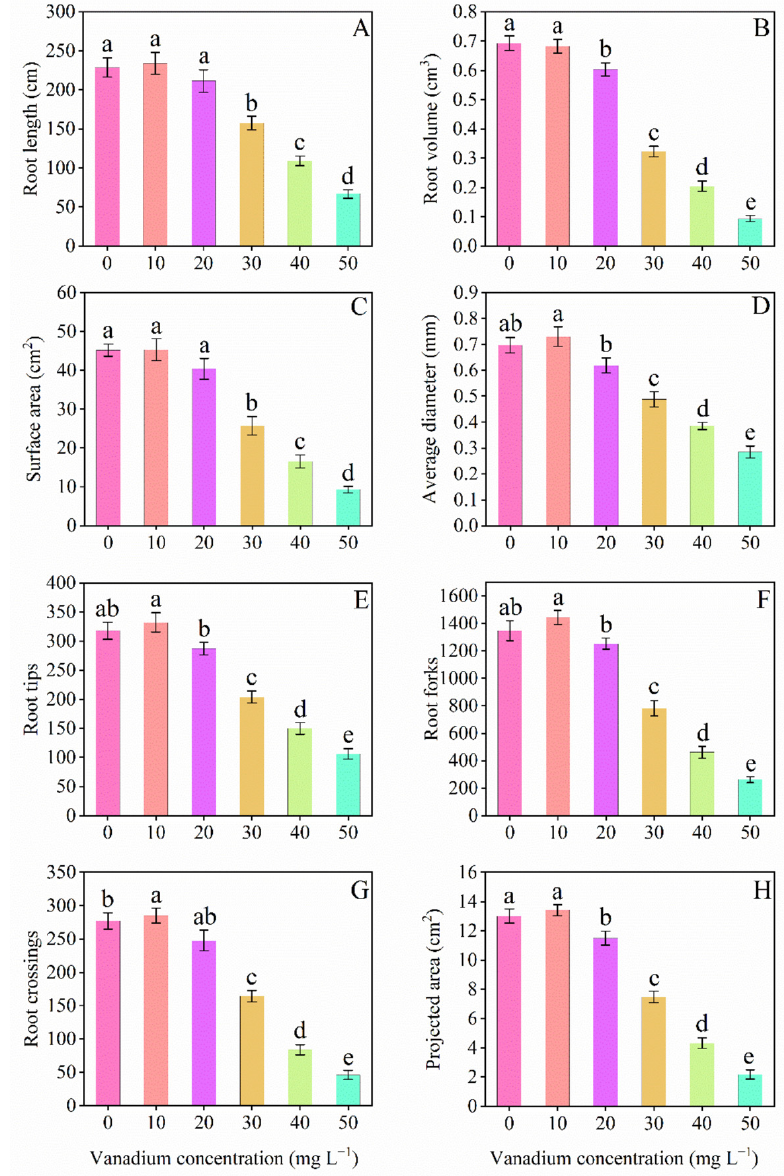
Figure 3. Effect of vanadium on root morphology [Root length ( A ), root volume ( B ), surface area ( C ), average diameter ( D ), root tips ( E ), root forks ( F ), root crossings ( G ), and projected area ( H )] in pepper seedlings. Means ± SE, n = 4, significant differences are exhibited by lowercase letters (at p < 0.05), according to Fisher’s least significant difference